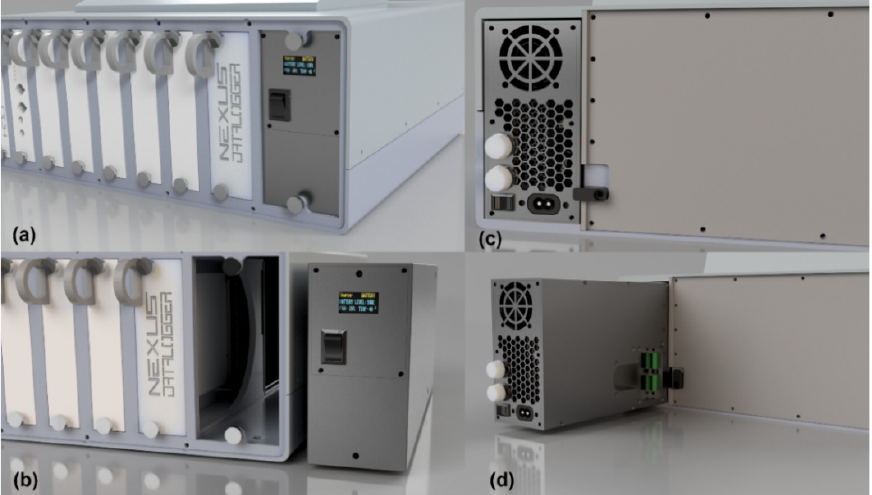
Figure 9. Mechanical project: ( a ) the power supply inserted in the data logger, ( b ) the power supply next to the data logger, ( c ) the backside of the data logger with the power supply inserted, and ( d ) the power supply removed from the data logger.